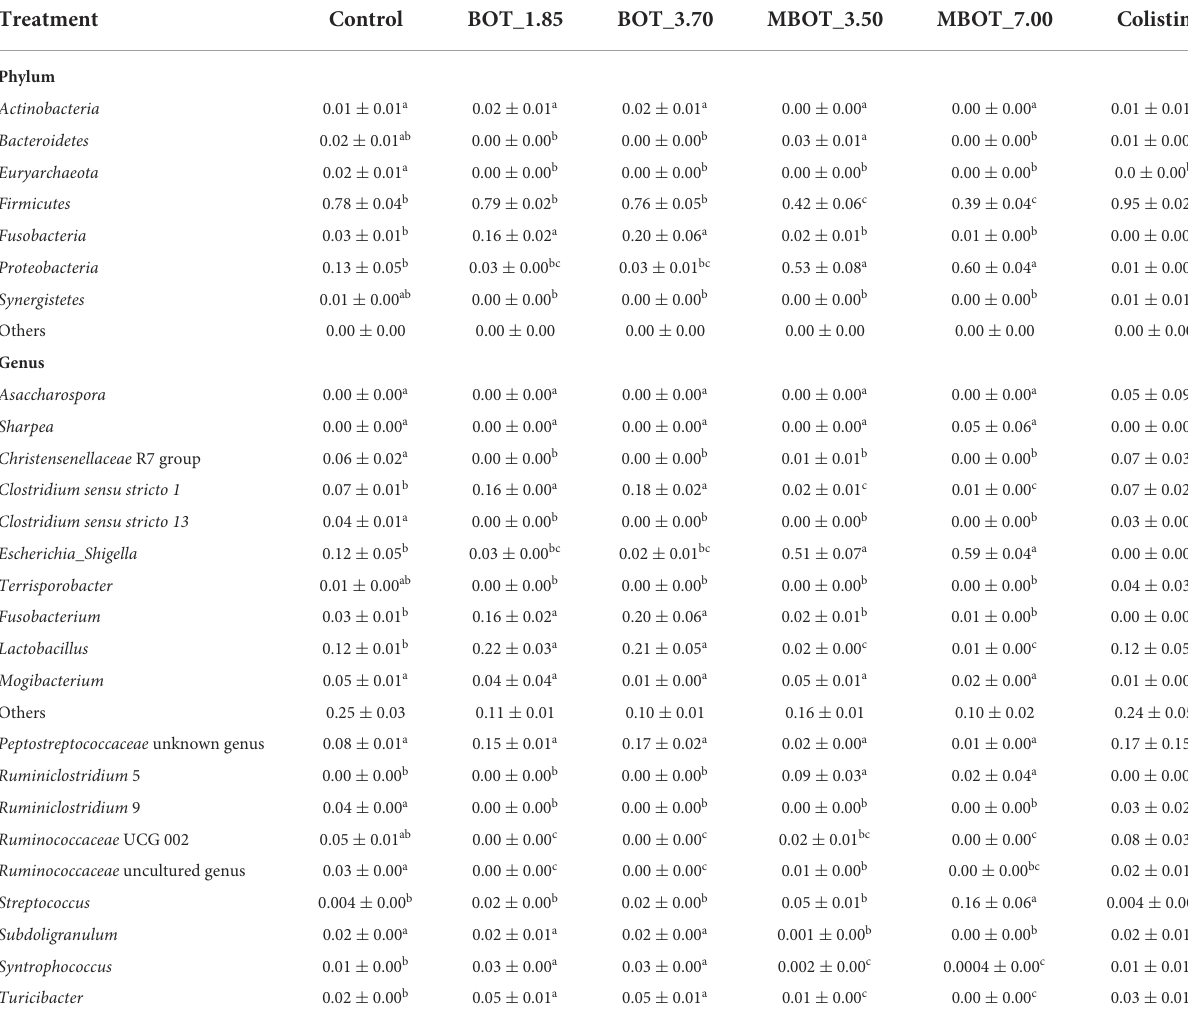
TABLE 4 Relative abundance * of phyla and genera after 72h of colon microbiota fermentation as the effect of BOT oil treatment, both unprotected (BOT) and microencapsulated (MBOT).